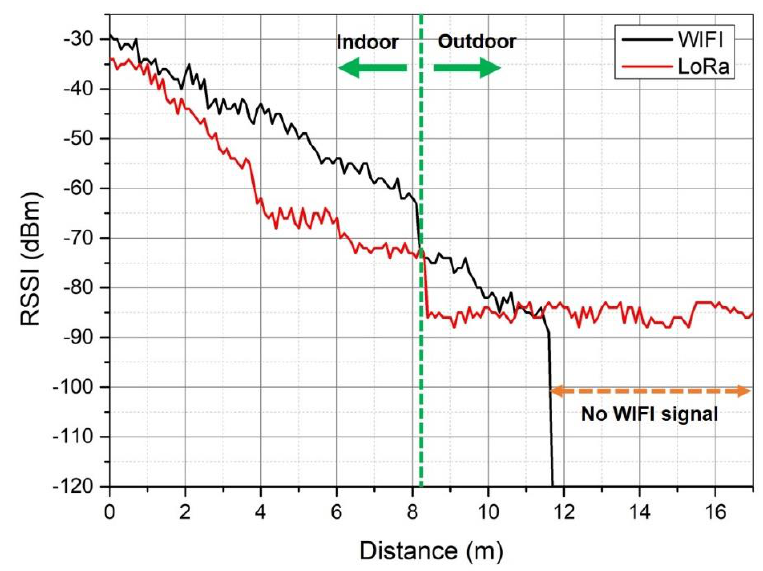
Figure 13. The RSSI measured in the house during the day.